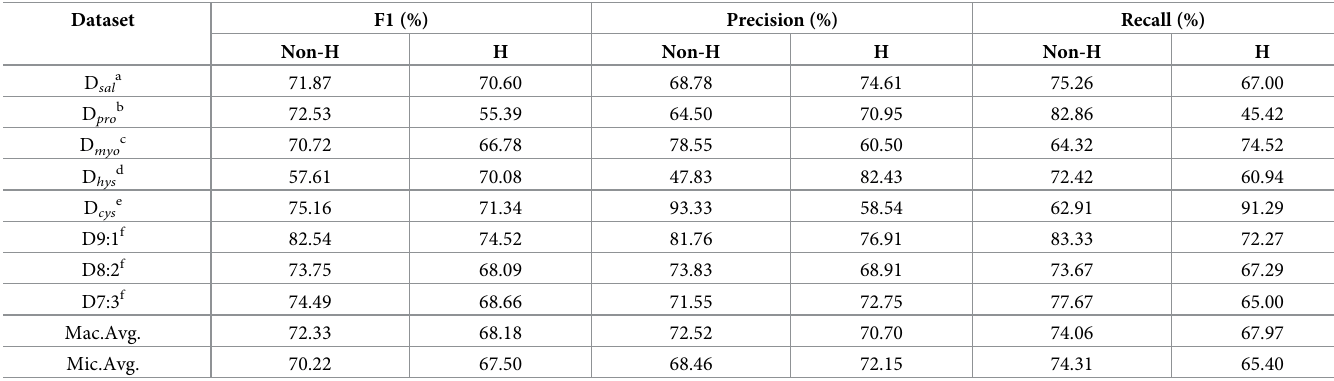
Table 4. Performance of the proposed model with different